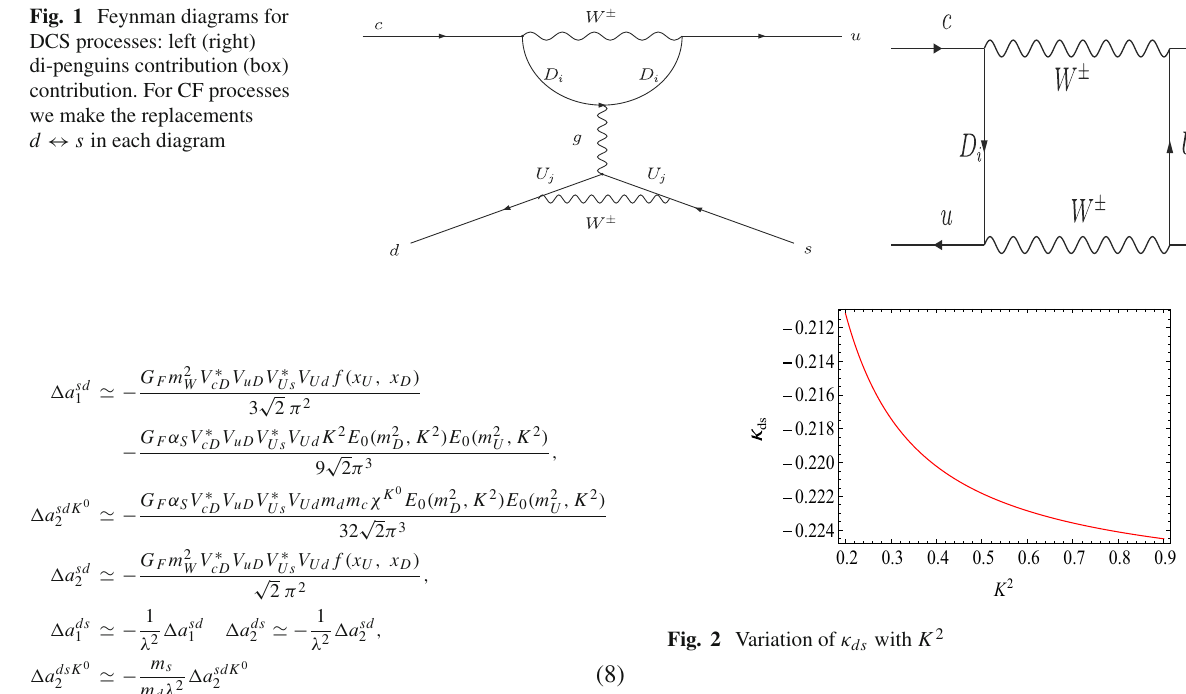
√ 2 π 3 ) (cid:3) 9 × 10 − 9 indicating